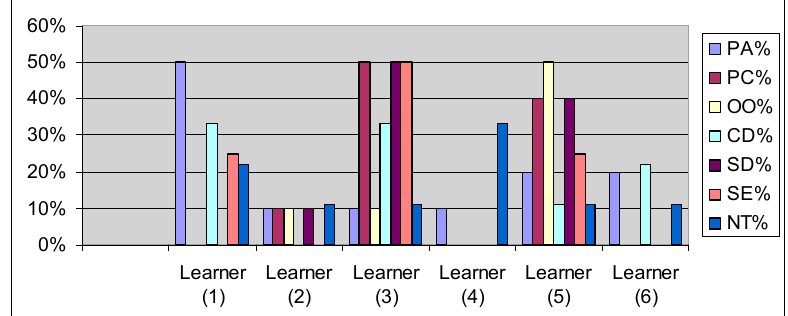
Figure 23. Learners’ participation ratio for Group 2.